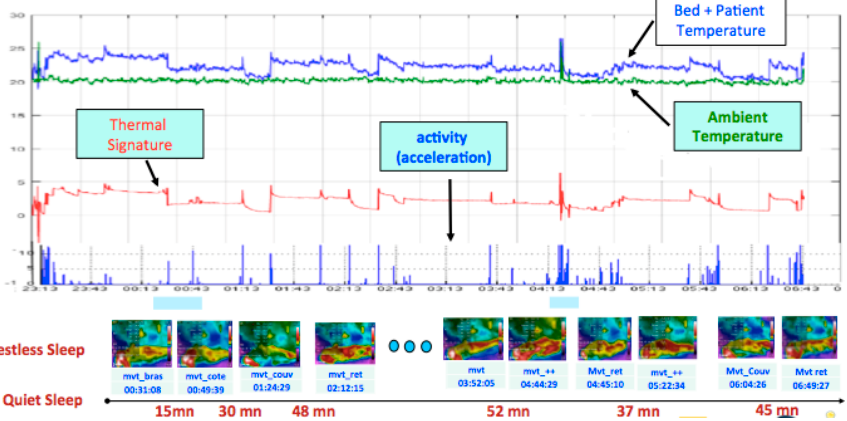
Figure 7. The evolution of the ambient temperature, the temperatures of the bed and the patient, and the acceleration of the movement of the wrist. The thumbnail images represent the instants associated with movements, and the durations corresponding to rest periods without activity are displayed.